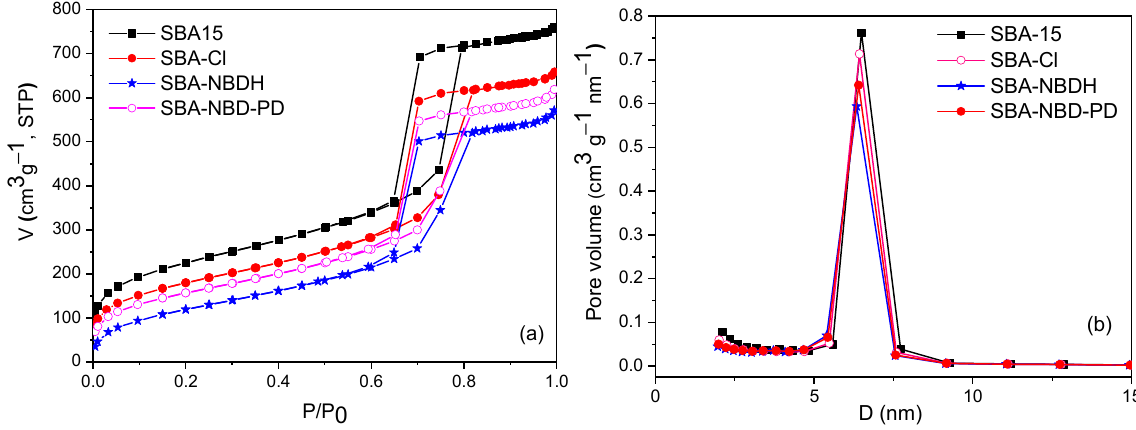
Figure 1. FTIR spectra of pure SBA-15, SBA-Cl, SBA-NBDH, and SBA-NBD-PD. N 2 adsorption–desorption isotherms (Figure 2a) were recorded on pristine SBA-15, SBA-Cl, and the NBD-functionalized SBA-15. All four isotherms are of type IV with an H1 hysteresis loop, according to IUPAC classification [25], typical for mesoporous materials with regular pore structure. The textural parameters (BET surface area, total pore volume, and average pore size) are listed in Table 1. The decrease in pore volumes and BET surface areas of SBA-Cl and functionalized SBA-15 samples in comparison with those of the pure SBA-15 can be attributed to the presence of functional groups on the internal walls of pore channels that partially obstruct the adsorption of nitrogen. The physisorption data indicate a uniformity of the functional groups’ distribution and a preservation of the regularity of the mesoporous structures after functionalization. Figure 2b indicates that the pore size distribution for the NBD-functionalized samples is very close to that of the SBA-15 sample, the peak maxima being slightly shifted to lower values. However, the average pore size values are similar, as can be seen in Table 1.